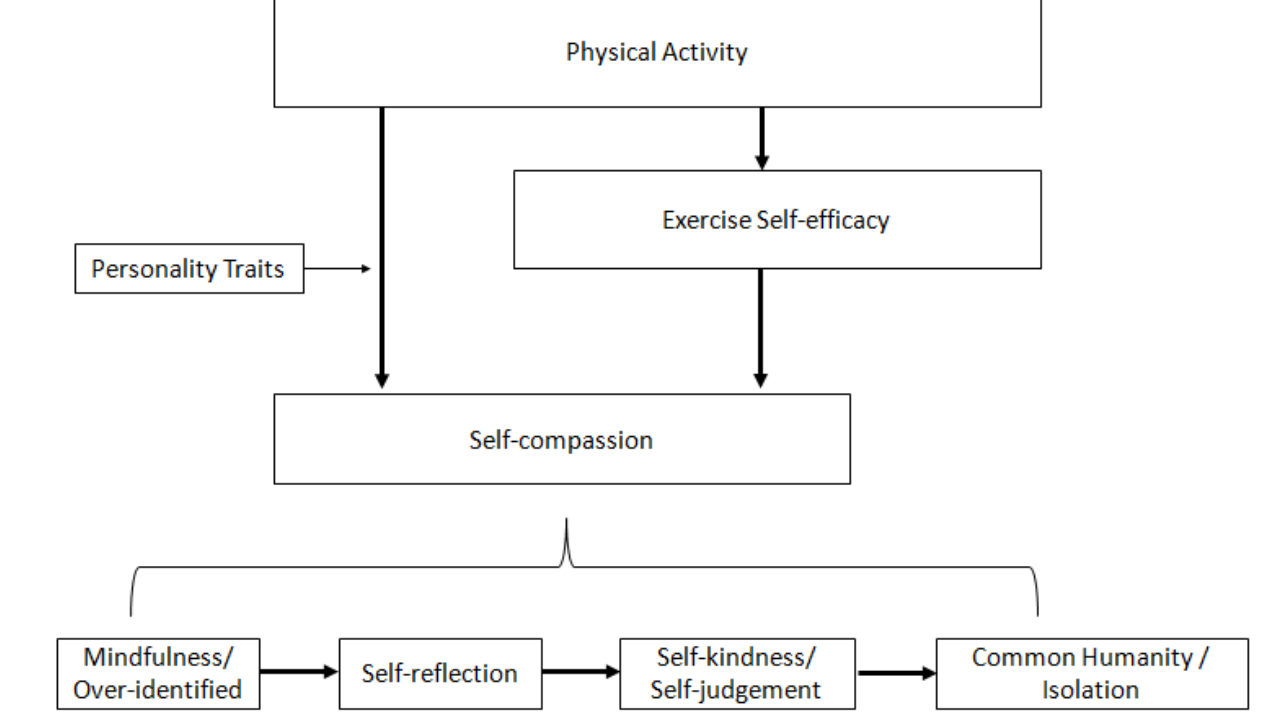
Figure 4. The Relationship between Physical Activity and Self-Compassion. Note. This figure indicated the path from physical activity to self-compassion through exercise self-efficacy. On the other hand, it also indicates the possible mediating effect of personality on physical activity and self-compassion. Additionally, the four sub-categories under self-compassion were shown and demonstrated their processing stage from mindfulness towards common humanity.